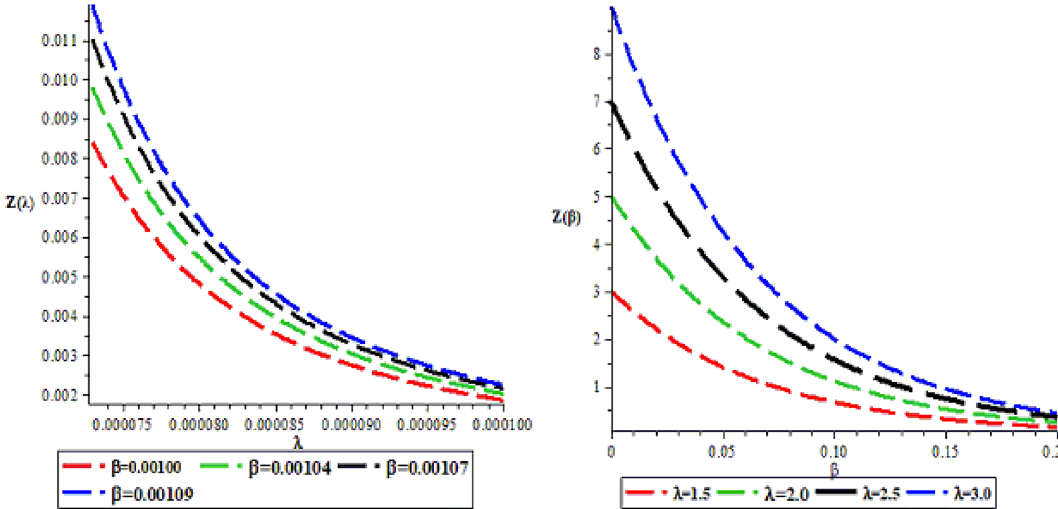
Figure 2. The variation of vibrational partition function against the maximum quantum state (λ) and temperature parameter (β) respectively.